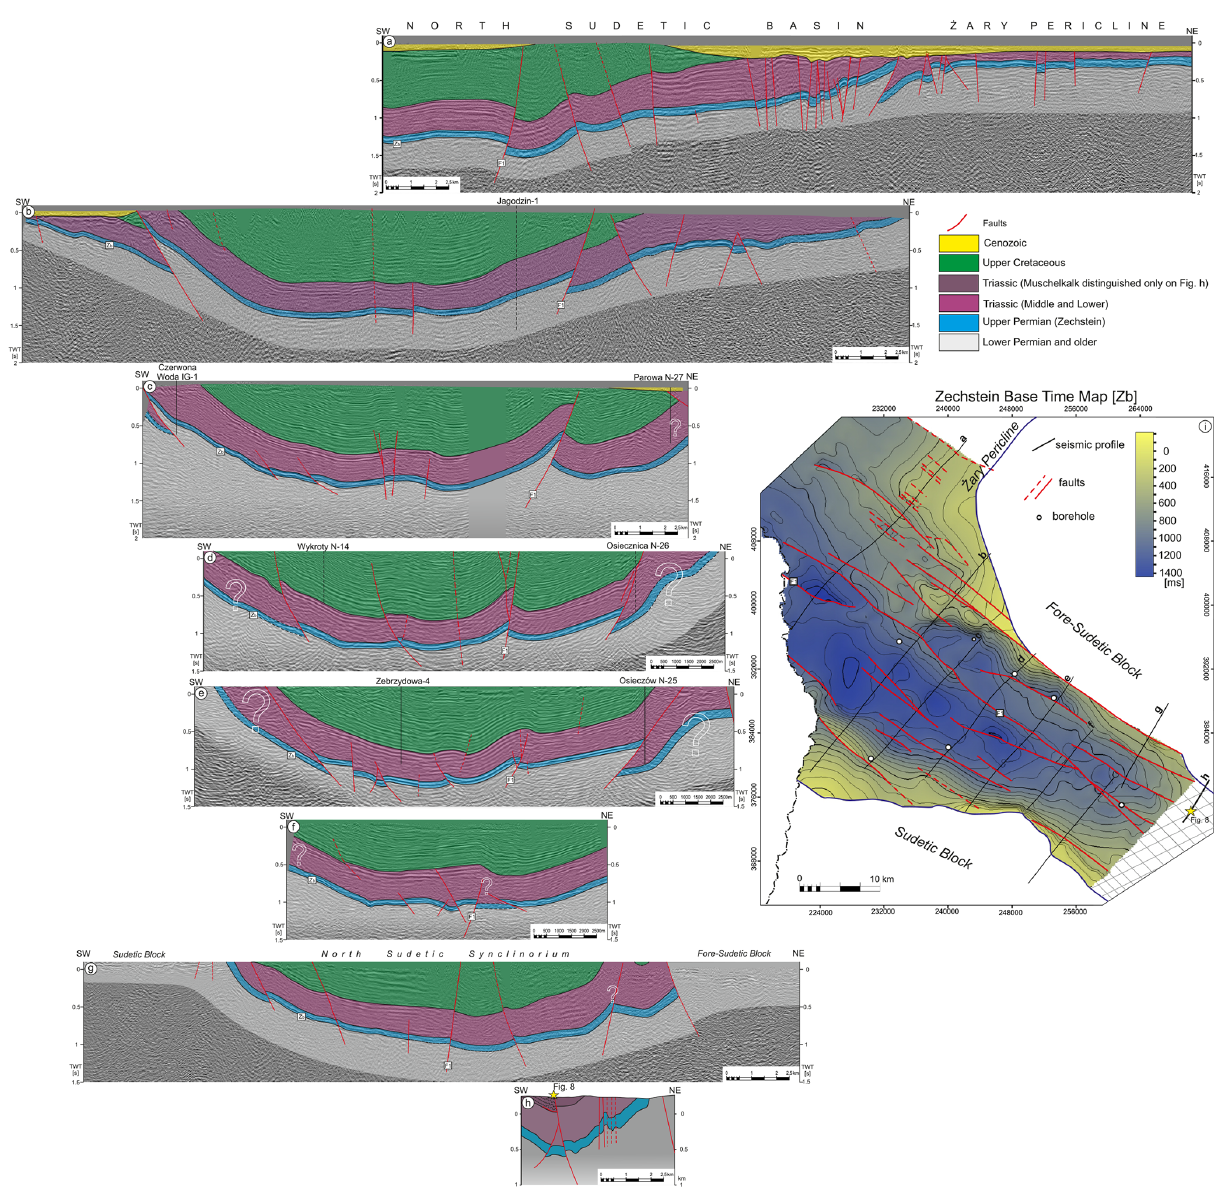
Figure 9. Interpreted seismic profiles from the North Sudetic Synclinorium (location in Fig. 6). Explanations in the